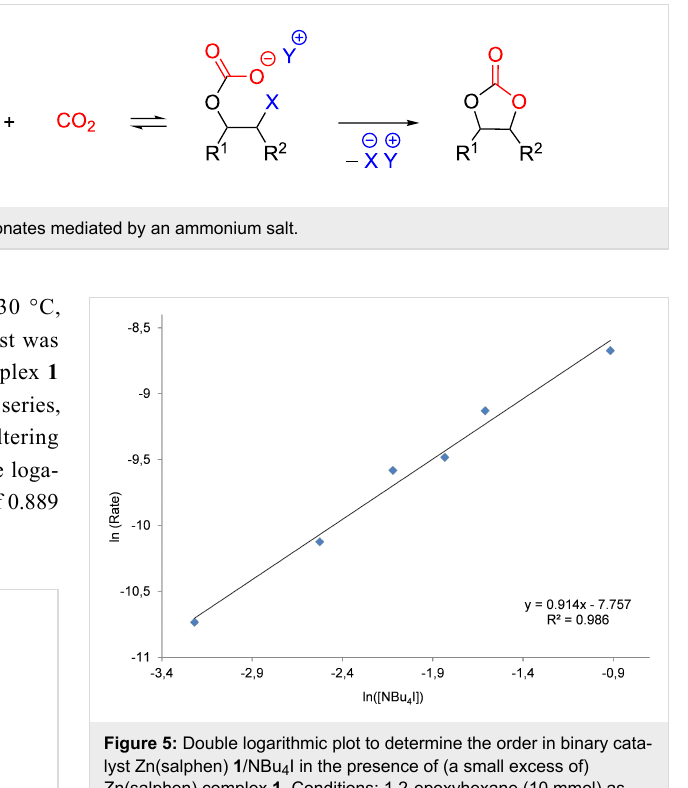
Figure 5: Double logarithmic plot to determine the order in binary cata- lyst Zn(salphen) 1 /NBu 4 I in the presence of (a small excess of) Zn(salphen) complex 1 . Conditions: 1,2-epoxyhexane (10 mmol) as substrate, 30 °C, 1 MPa of CO 2 , 2 h; [Zn] = 0.2 mol %, [NBu 4 I] = 0.04–0.4 mol %. For the steady state domain using two different concentrations of binary catalyst please refer to Supporting Informa- tion File 1, Figure